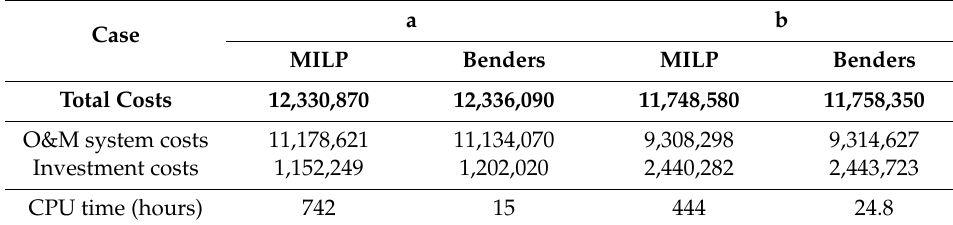
Table 4. Total system costs ( € ).